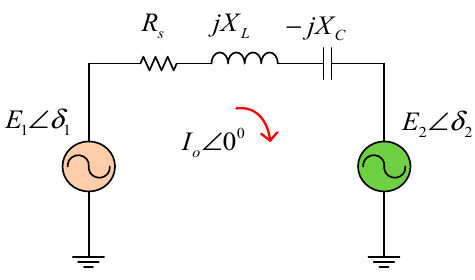
Figure 3. Phasor model of the DAB-SRC at the steady-state condition.